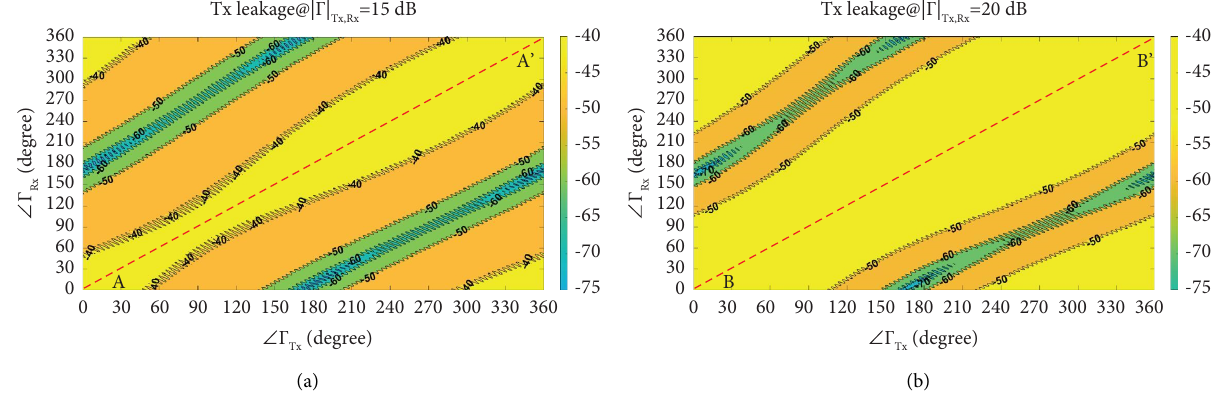
� (a) 15dB and (b)20dB Txa,Rxa